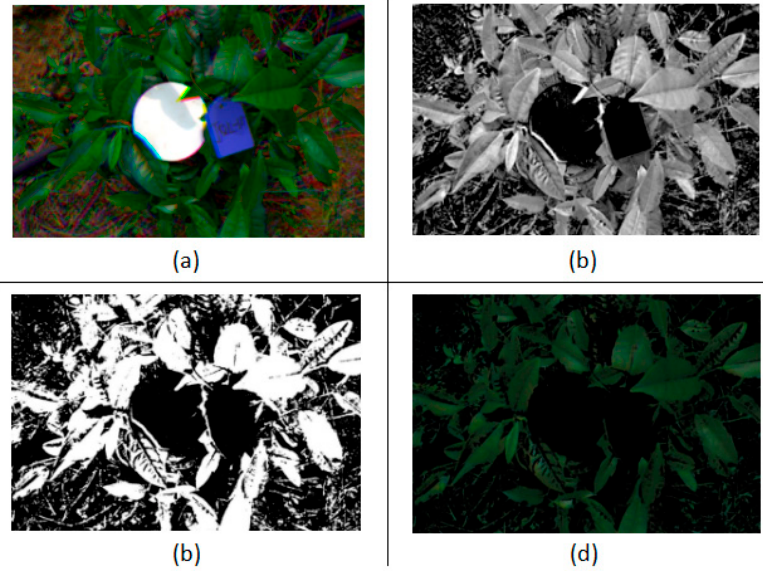
Figure 5. Images corresponding to the different steps of the background removal process. ( a ) Original image, ( b ) image enhanced by the EXG index, ( c ) binary image segmented by the Ostu method, and ( d ) image acquired after masking the background.